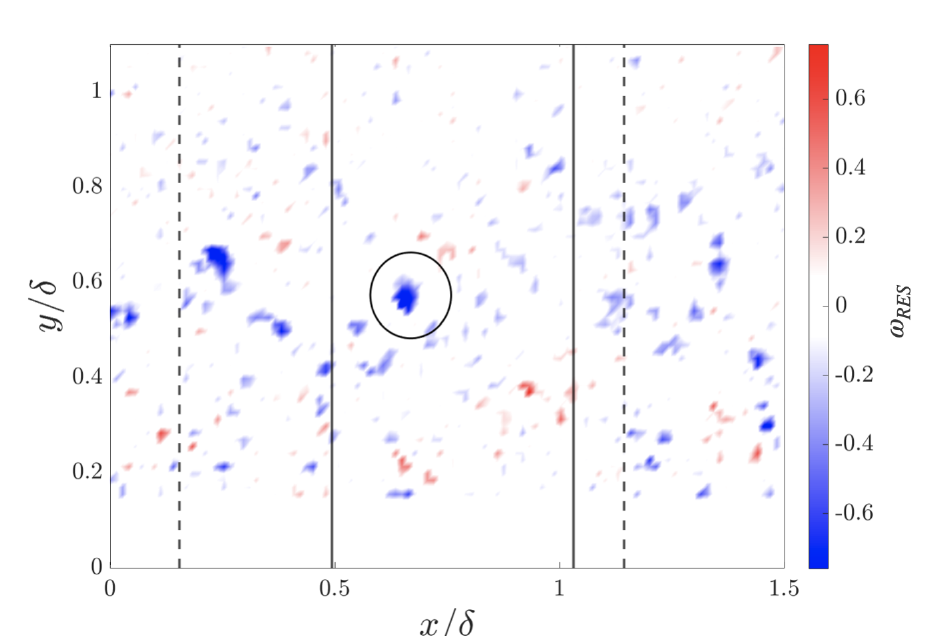
Figure 1. A contour plot of ω RES , highlighting regions of coherent rotation in the flow. The black ellipse indicates a strong peak in ω RES , corresponding to the locally strongest spanwise vortex. The solid vertical lines indicate the streamwise width of the region of vortex identification while the dotted vertical lines indicate the sampling window for the large-scale velocity field. The sampling window is differently placed for each snapshot and is always decided such that the identified vortex is in the center in the streamwise direction while the region of vortex identification is same for all snapshots.